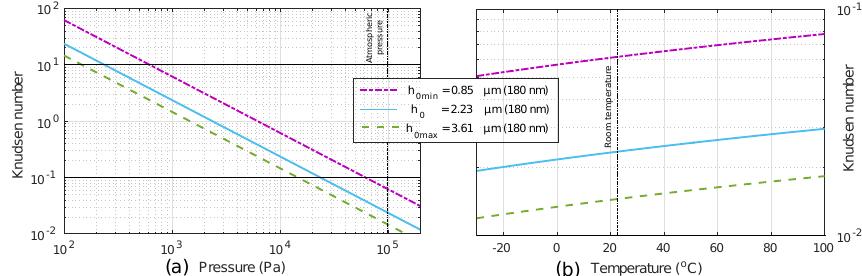
Figure 2. Knudsen regimes variation according to gap distance of the prototypes. ( a ) The K n theoretical regimes for the prototypes with pressure sweep at a constant temperature of 23 ◦ C. ( b ) The K n theoretical regimes for the prototypes with temperature sweep at a constant environment pressure of 110